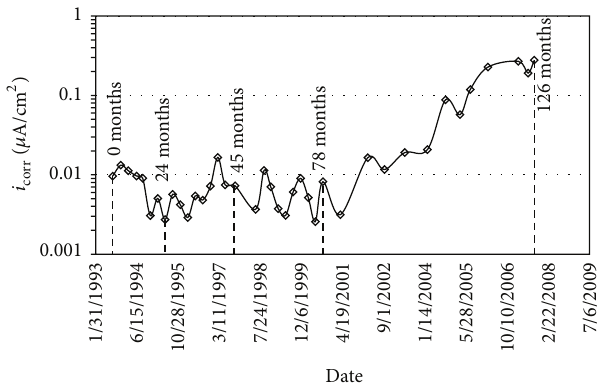
Figure 6: Value for 𝑖 corr over time; values are greater than > 0.1 𝜇 A/ cm 2 at 126 months.